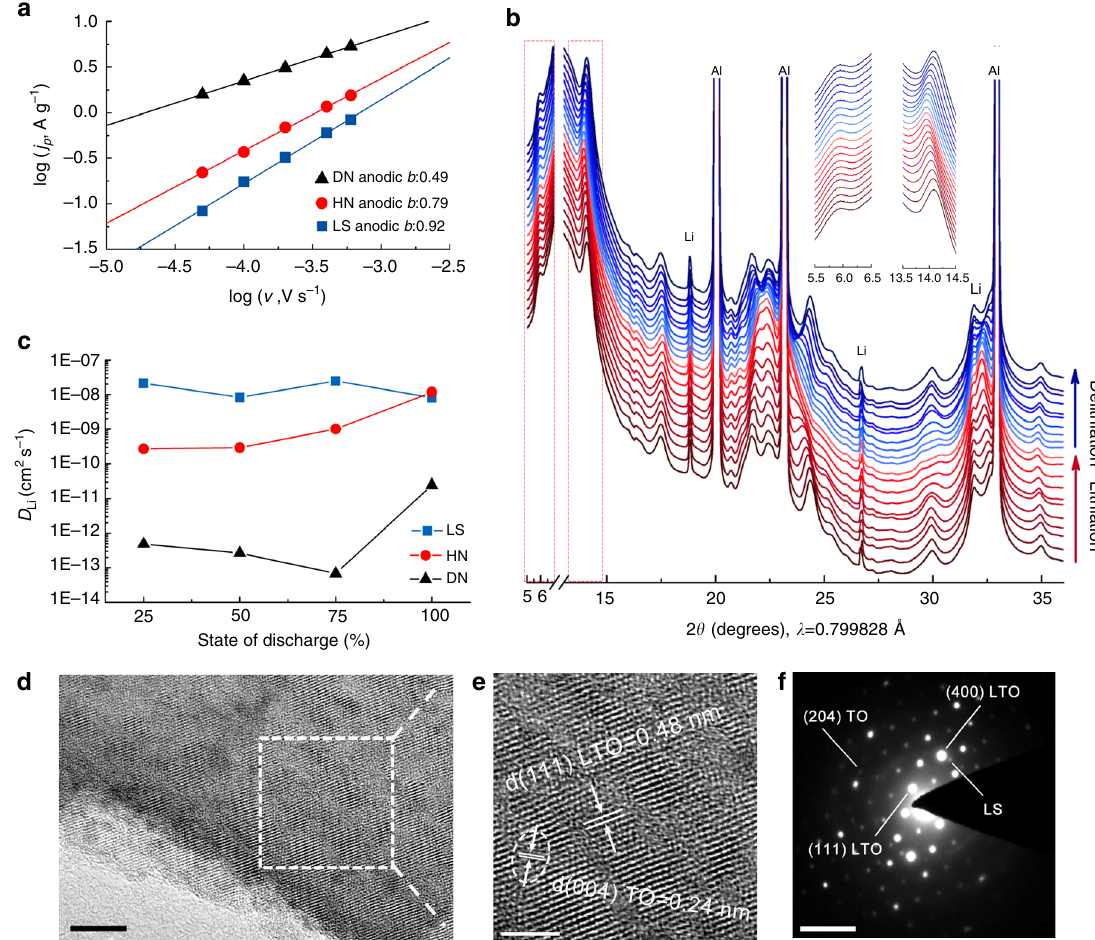
Fig. 4 Illustration for electrochemical performance enhancement mechanism of lithium titanate hydrates. a , b -values determination of anodic peaks with sweep rate from 0.05 mV s − 1 to 0.6 mV s − 1 for LS, HN and DN electrodes; b in situ synchrotron XRD results during the third cycle of LS electrode cycled at 100 mA g − 1 , some main peaks of LS at 6° and 14° are highlighted in the insert; c Li-ion diffusion coef fi cient at various state of discharge; d HRTEM image of a HN nanosheet ( scale bar , 10 nm) and e Magni fi ed image of the selected region in d with a spacing of 0.48 nm of Li 4 Ti 5 O 12 and 0.24 nm of TiO 2 ( scale bar , 5 nm); f SAED pattern of HN ( scale bar , 5